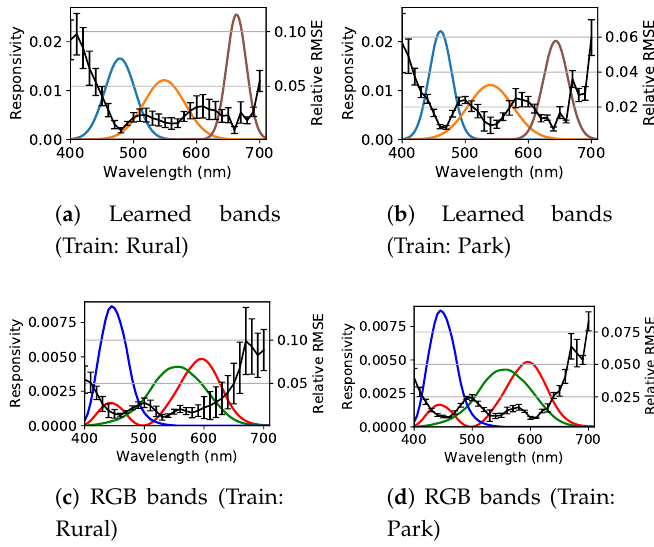
Figure 4. Responsivity of our learned bands and average relative root mean square error (RMSE) across reconstructed bands (black line) for Outdoor scenes